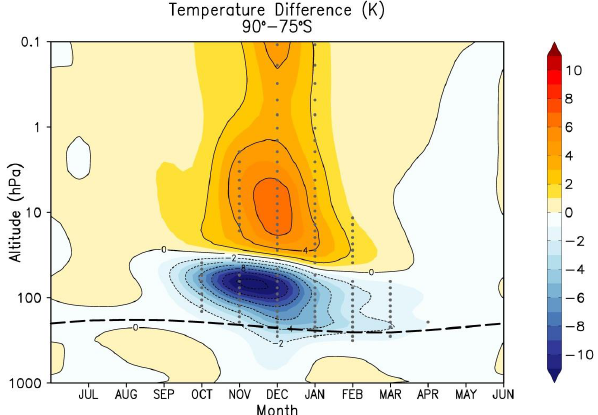
Figure 4: Zonal mean, monthly mean zonal wind REF2000 climatology (contours) and Figure 4. Zonal mean, monthly mean zonal wind REF2000 cli- Figure 3: Zonal mean, monthly mean temperature difference between REF2000 and NHC, Figure 3. Zonal mean, monthly mean temperature difference be- matology (contours) and difference between REF2000 and NHC difference between REF2000 and NHC (shaded), averaged over 70°-50°S. Contour intervals tween REF2000 and NHC, averaged over 90–75 ◦ S. Contour in- averaged over 90°-75°S. Contour intervals are 2 K, solid/dashed contours represent (shaded), averaged over 70–50 ◦ S. Contour intervals are 10ms − 1 ; are 10 m s -1 , solid/dashed contours represent positive/negative changes. The 0 m s -1 contour tervals are 2K, solid/dashed contours represent positive/negative positive/negative changes. Stippling denotes significance at the 95% confidence level. The solid/dashed contours represent positive/negative changes. The changes. Stippling denotes significance at the 95% confidence is highlighted in bold. Stippling denotes significance at the 95% confidence level. The bold bold dashed line signifies the tropopause height in the REF2000 simulation. 0ms − 1 contour is highlighted in bold. Stippling denotes signifi- level. The bold dashed line signifies the tropopause height in the dashed line signifies the tropopause height in the REF2000 simulation. cance at the 95% confidence level. The bold dashed line signifies REF2000 simulation. the tropopause height in the REF2000